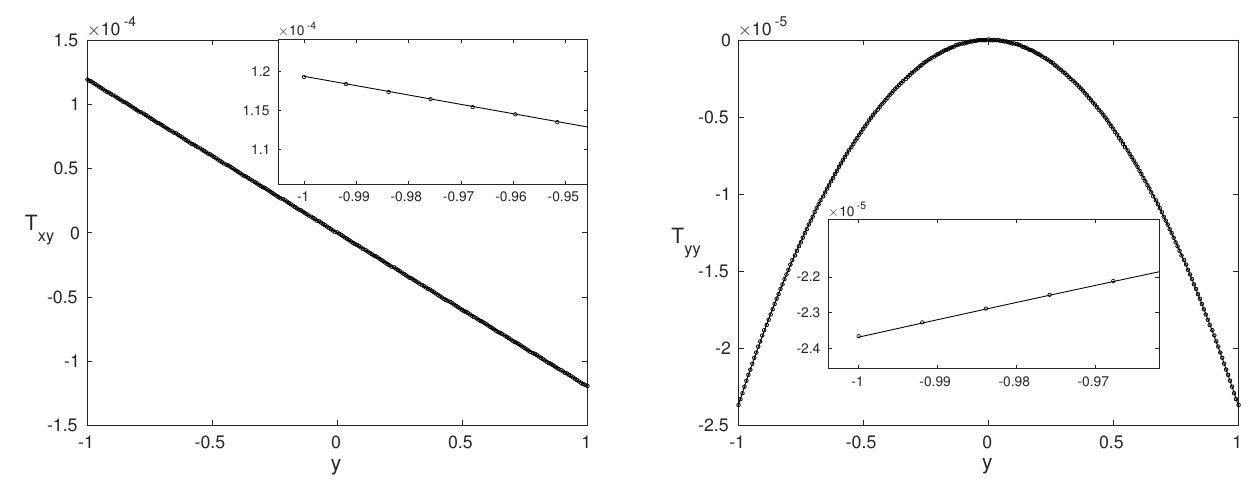
Figure 6. Same as in Figure 1 for dimensionless numbers: Re = 8000, β = 0, α G = 0.1 and Wi = 2. The extra-stress tensor results obtained by the formulations of Schleiniger and